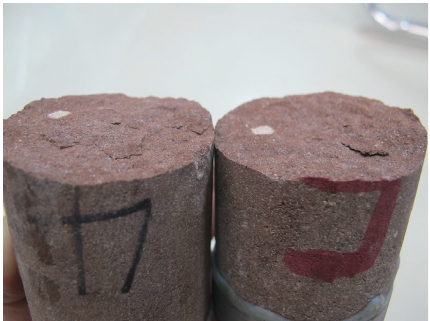
Figure 7: Specimen failure mode in direct tensile